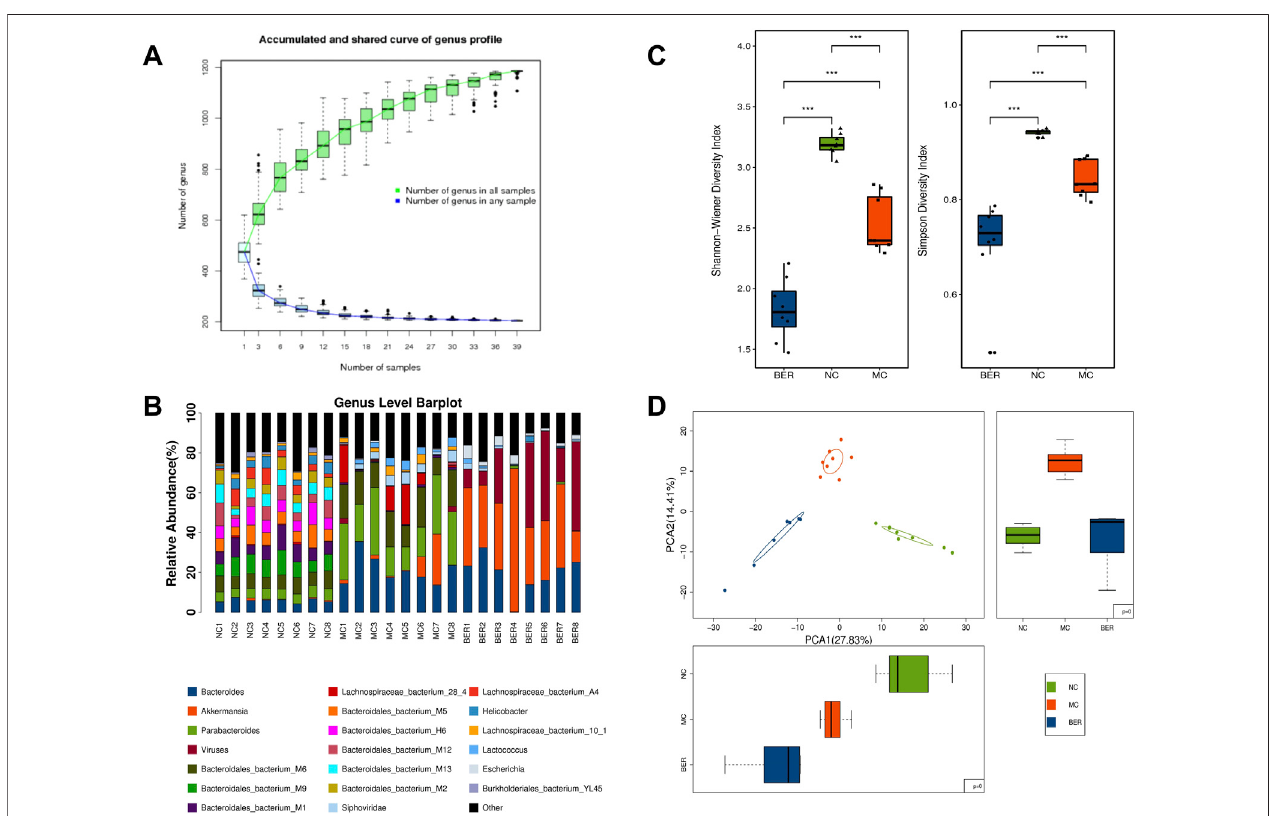
FIGURE 2 | Decreased diversity and gut microbiota structure altered in the MC group and BER group. (A) The species accumulation curves. The abscissa representsthenumberofsamples,and theordinaterepresentsthenumberofspeciesafter sampling. (B) Thegenusleveloftherelativeabundancebarplot.Itshowsthe top 20 species composition of each sample, while the sum of the abundance of species other than the top 20 is represented in black. (C) Box chart of the Shannon- Wiener index and Simpson index. *0.01 < p < 0.05; ** p < 0.01. (D) Principal-component analysis plot.